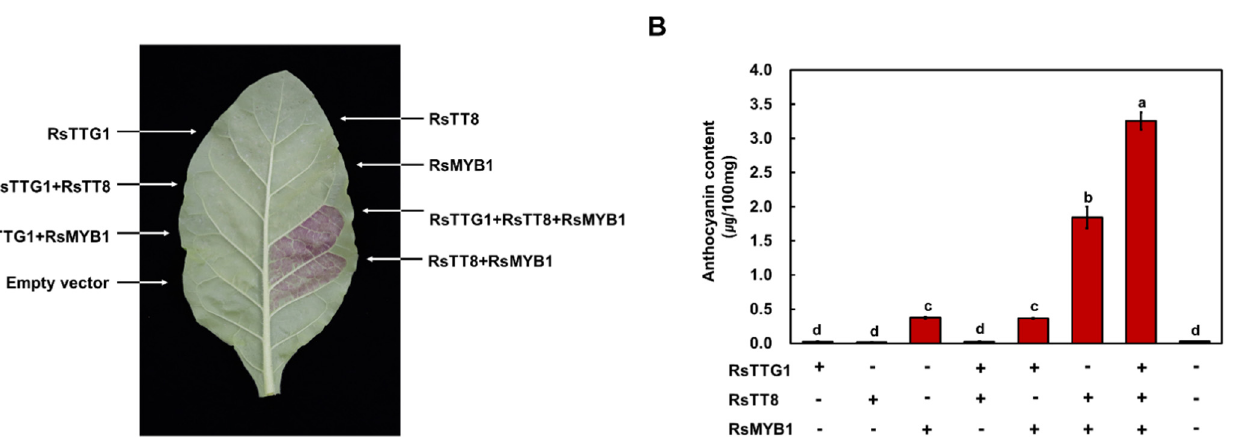
10 of 18 Figure 6. Transcriptional activation assay of the RsCHS and RsDFR promoters by RsTTG1, RsTT8, and RsMYB1. ( A ) Schematic diagrams of effector and reporter constructs used in the transcriptional activation assay. The effector construct harbors the coding sequence of RsTTG1, RsTT8, and